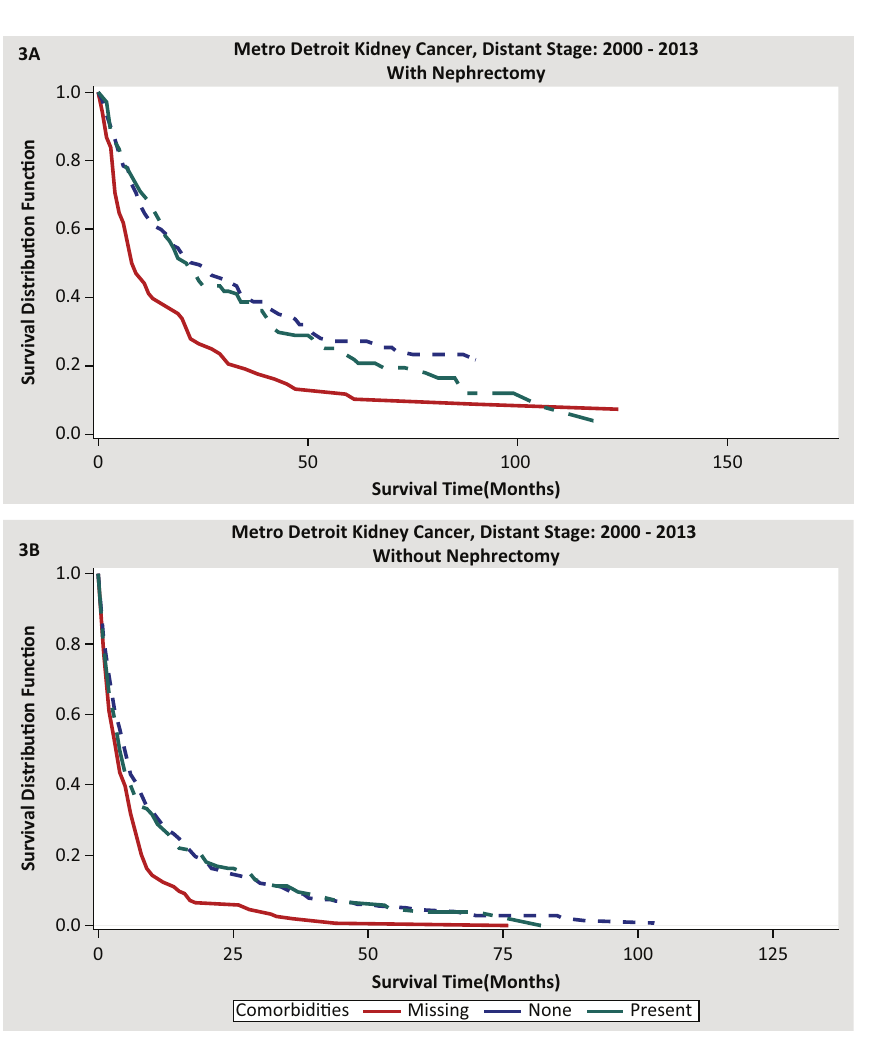
Figure 3: (A) Overall survival noted in cases with nephrectomy correlated with missing, absence, and presence of comorbidities. (B) Overall survival seen in cases with no nephrectomy correlated with missing, absence, and presence of